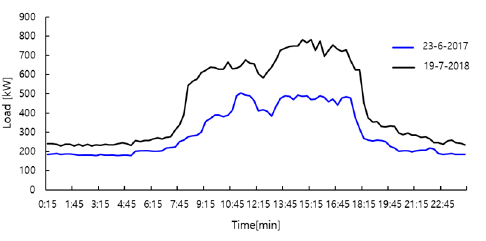
10 of 19 Figure 7. 30 June 2017 demand load profile. Algorithm 2: Variance Error Correction Model Input: